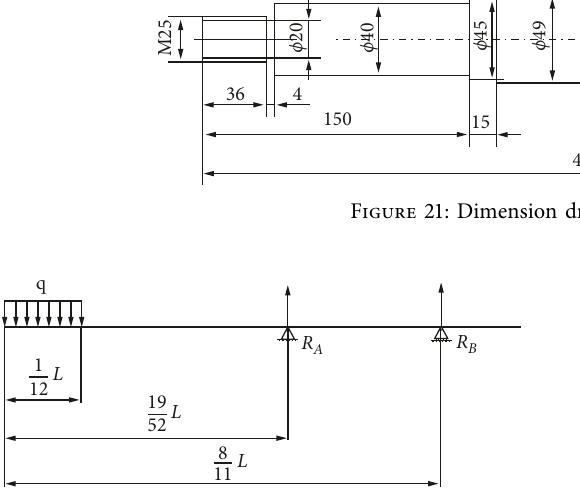
Figure 22: Mechanical diagram of the pump